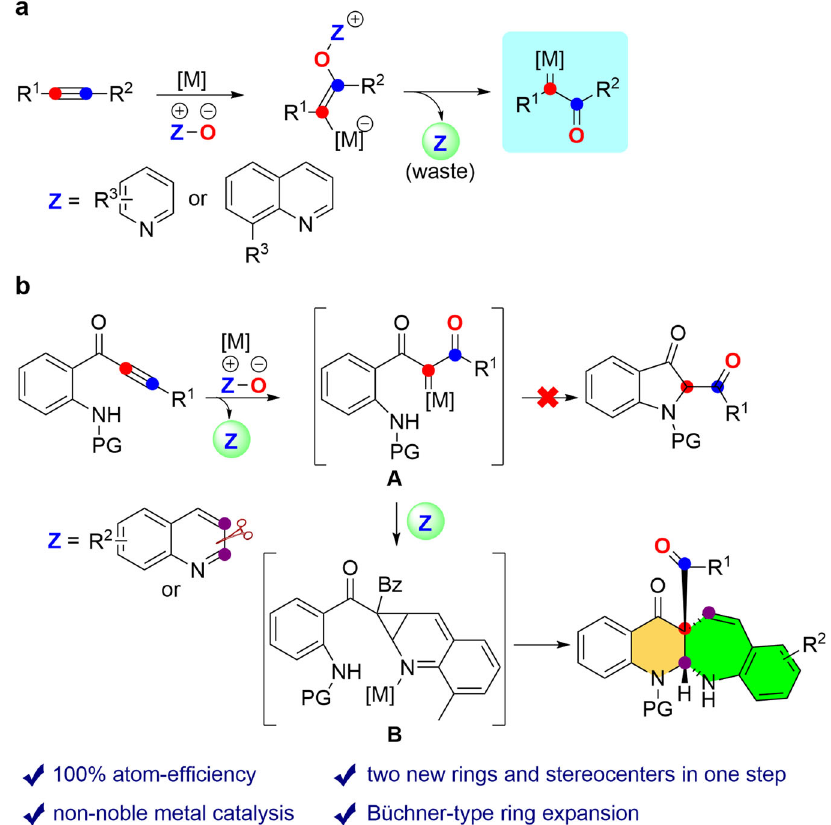
Fig. 1 Typical ways for the generation of α -oxo metal carbenes. a Previous work. b Our initial design. M